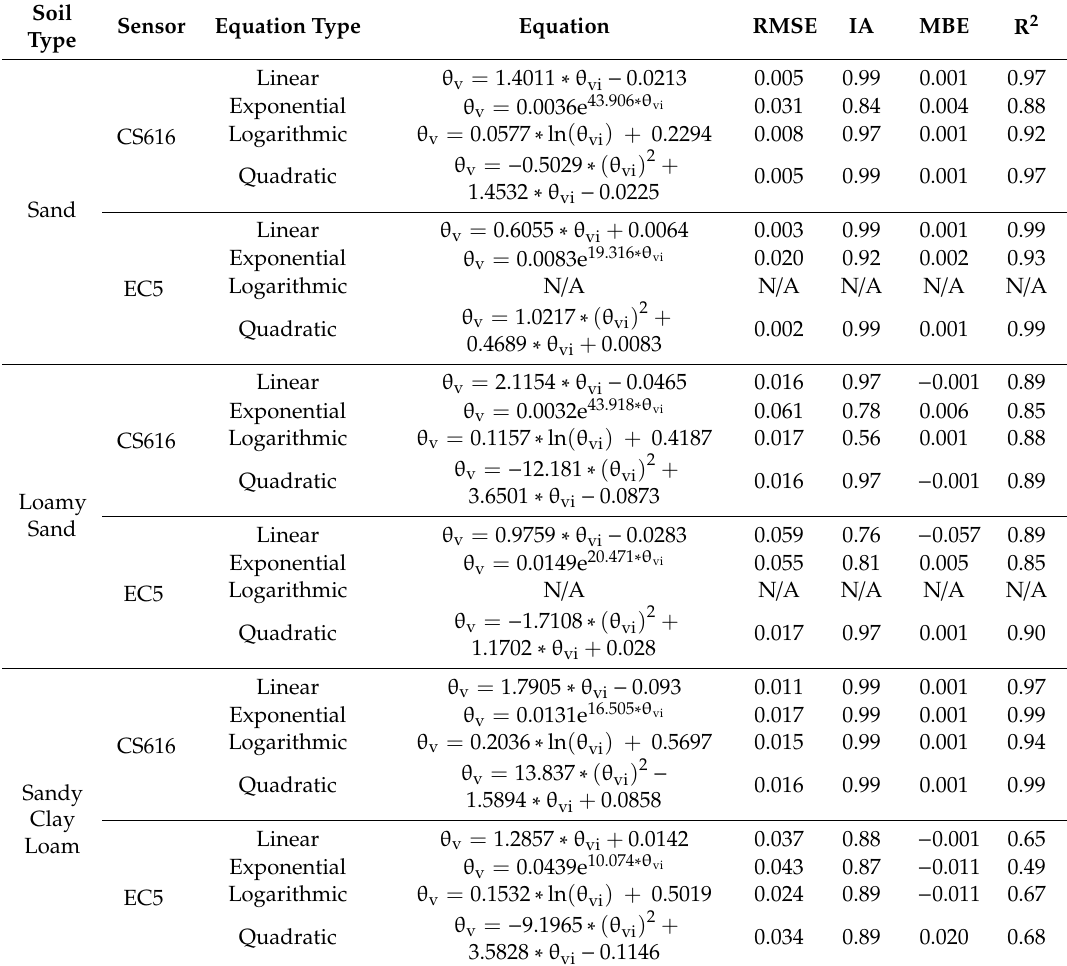
Table 4. Correction equations for CS616 and EC5 soil moisture